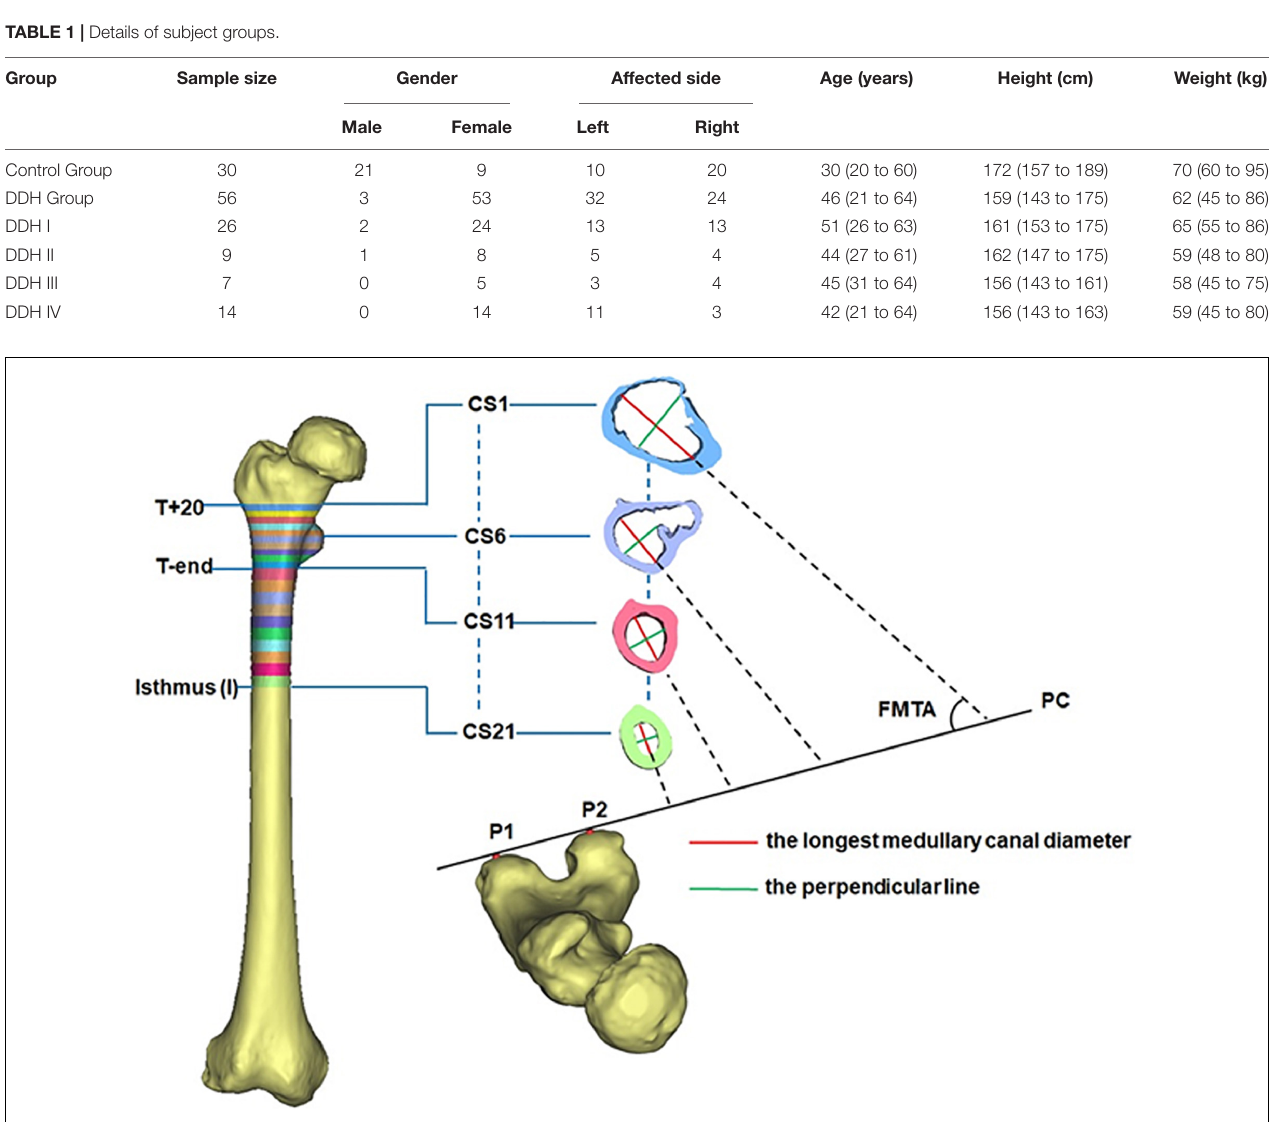
FIGURE 1 | The morphological measurement of the femoral medullary cavity.